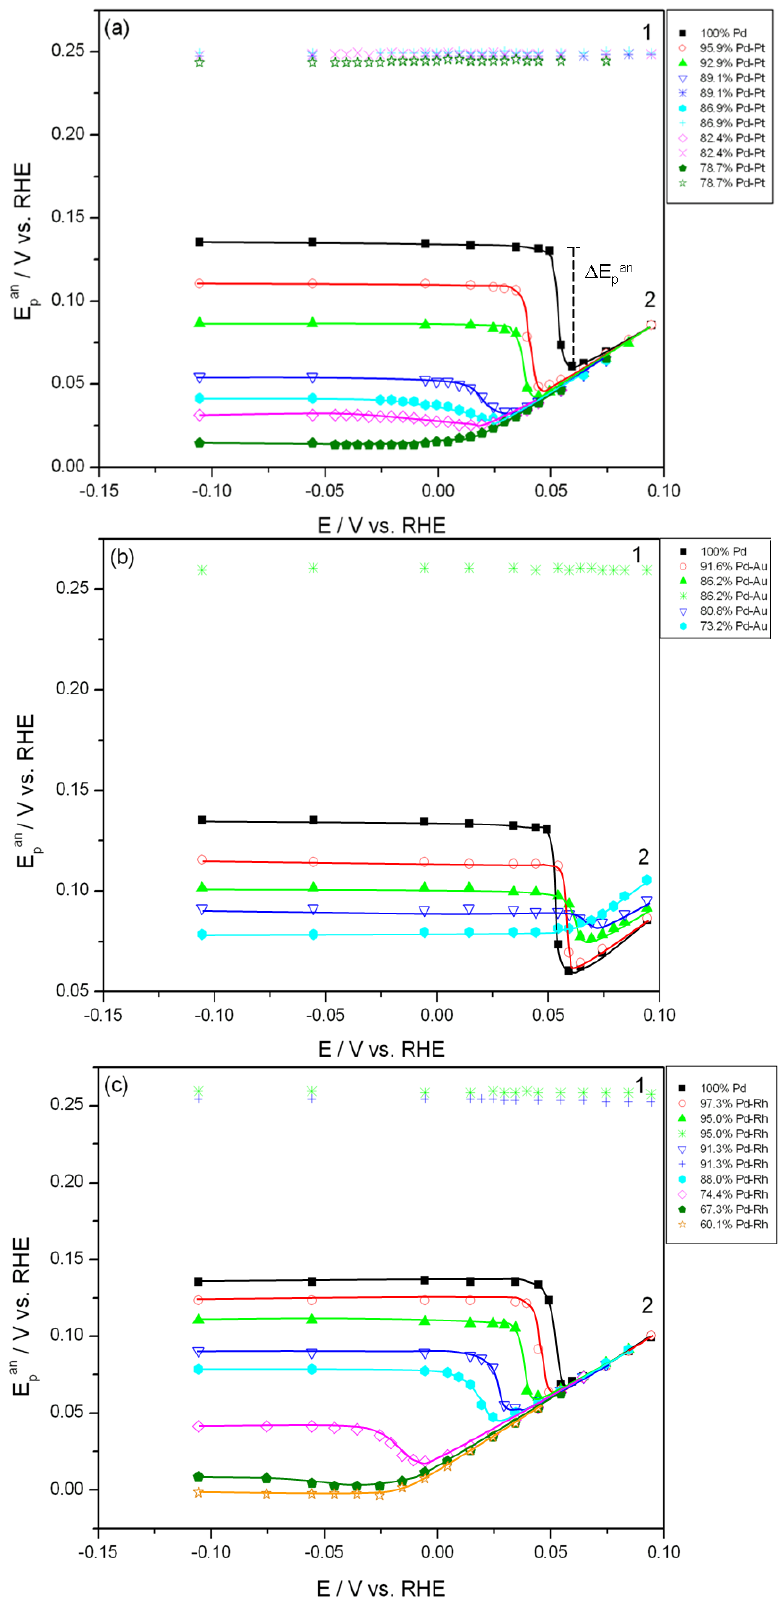
Figure 6. Influence of the electrosorption potential on the peak potential of anodic signals 1 and 2 for Pd alloys of various bulk compositions. Temperature 298 K. ( a ) Pd-Pt alloys; ( b ) Pd-Au alloys; ( c ) Pd-Rh alloys; ( d ) Pd-Ru